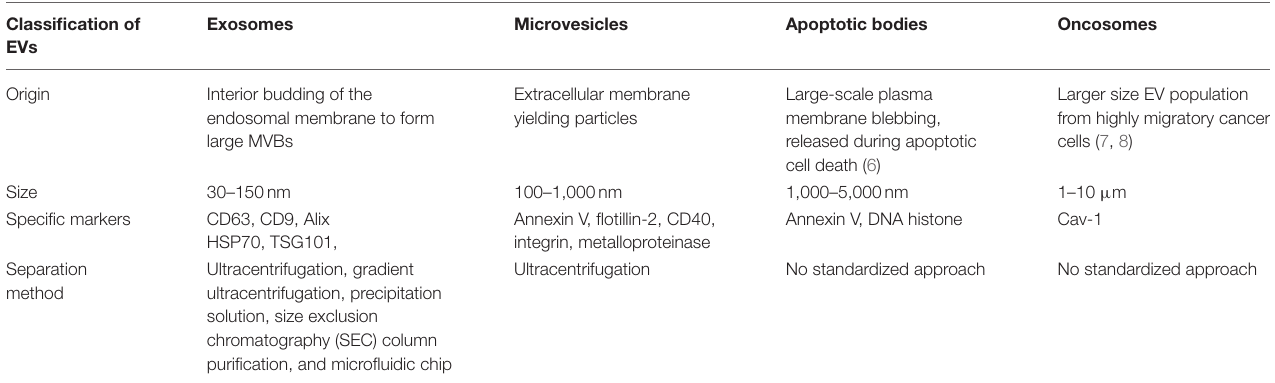
TABLE 1 | Comparison and classification of EVs according to their mechanism of generation. Classification of